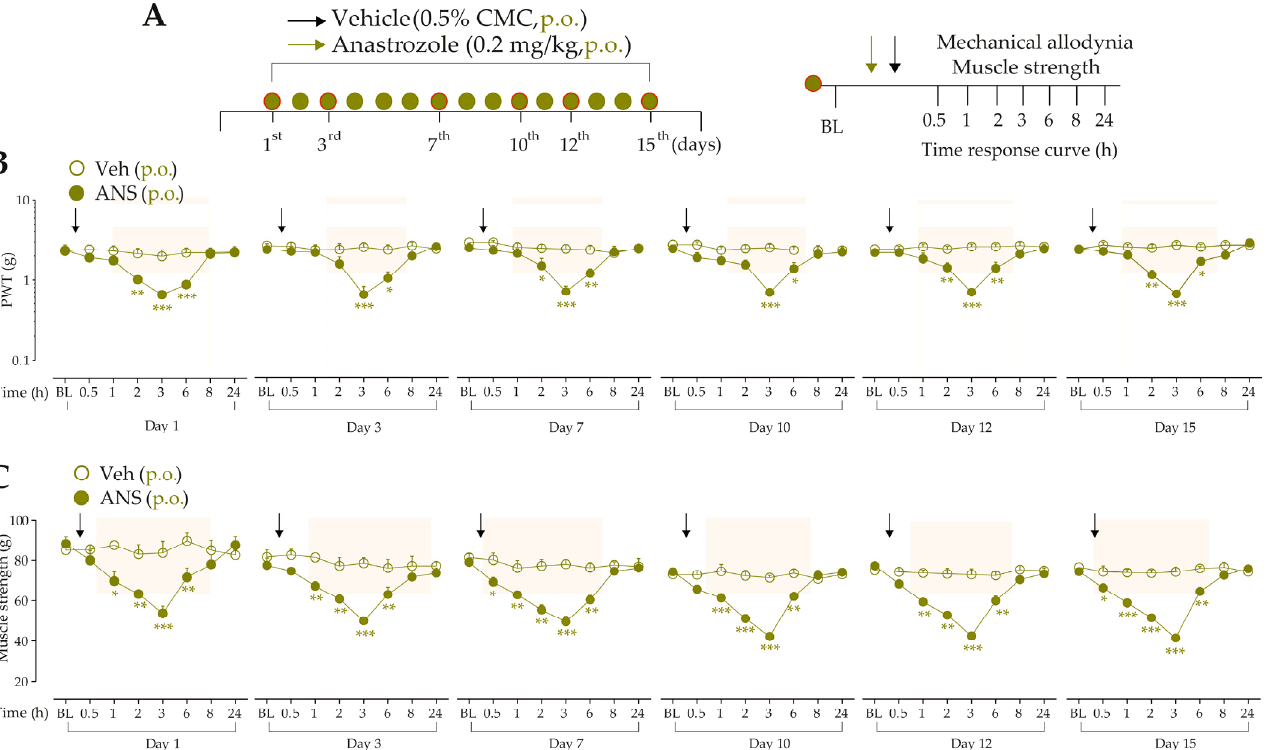
Figure 1. Repeated treatment with anastrozole induces prolonged nociceptive behaviors in mice ( A ) Male C57BL/6 mice were treated by the oral route (p.o.) with anastrozole (0.2 mg/kg) or its vehicle (0.5% CMC) once daily for fifteen days to mimic a 1-year time in humans. On the 1st, 3rd, 7th, 10th, 12th, and 15th days after treatments, a time curve (from 0.5 h up to 24 h) was performed to evaluate mechanical allodynia development and muscle strength loss ( B , C ). Baseline (BL) values were measured before anastrozole or vehicle administration. * p < 0.05, ** p < 0.01, and *** p < 0.001 vs. vehicle group. Data were expressed as the mean + SEM (n = 6/group) and analyzed by a two-way ANOVA followed by the Bonferroni post hoc test. The arrows indicate the administration of the anastrozole or vehicle. Veh: vehicle oral administration; ANS: anastrozole oral administration.